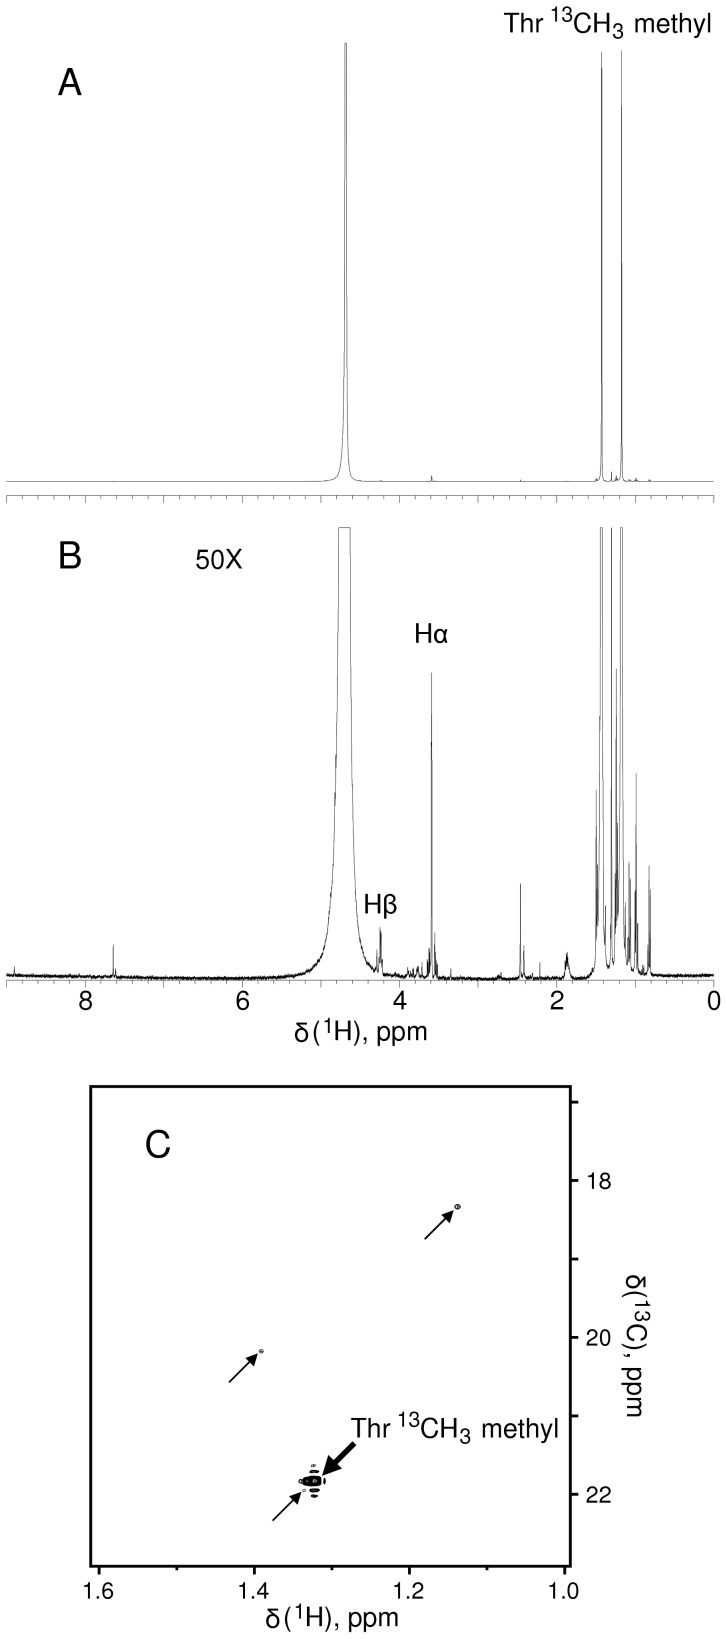
NMR spectra of L-[α-2H;β−2H;γ-13C]-Thr, 6.(A) 1H NMR spectrum with vertical scale adjusted to fit entire methyl doublet. (B) Same spectrum as in A with a 50-fold enhanced vertical scale. (C) 13C,1H HSQC spectrum of the same sample, 6. Contour level is set to 0.5% of the Thr methyl signal. The only 3 other peaks (all under 1% of the intensity of the Thr methyl) derive from impurities and are indicated with arrowheads. Approximately 2% residual protonation remains at the α position and much less at β.